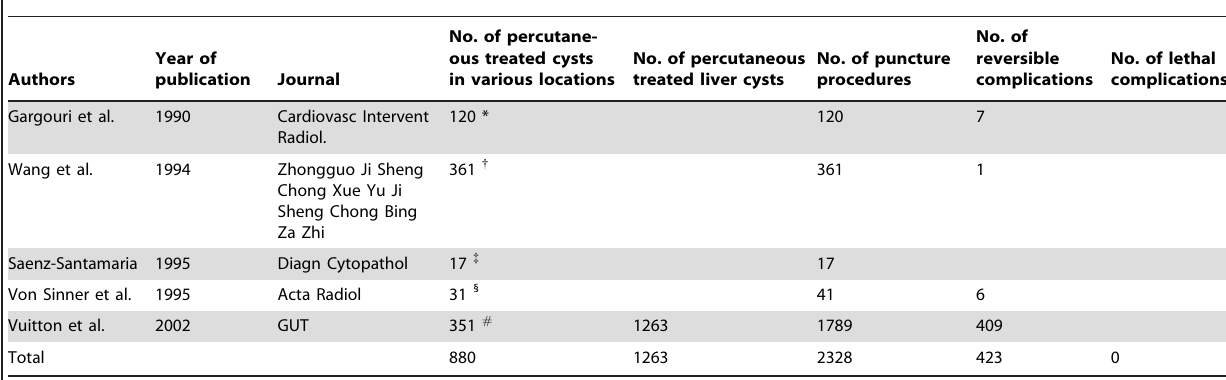
Table 1. Percutaneous treatment of hydatid cysts of various locations.